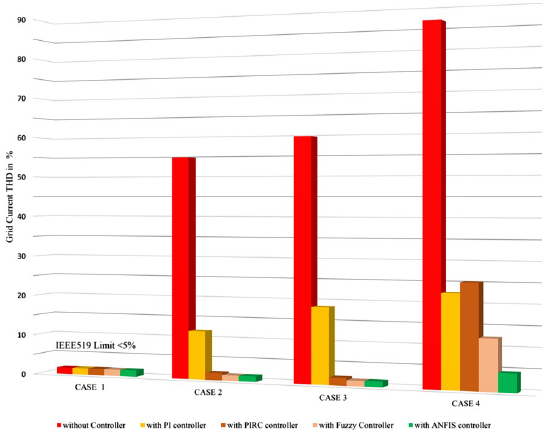
Fig. 22 Bar graph comparing THD% for all 4 case